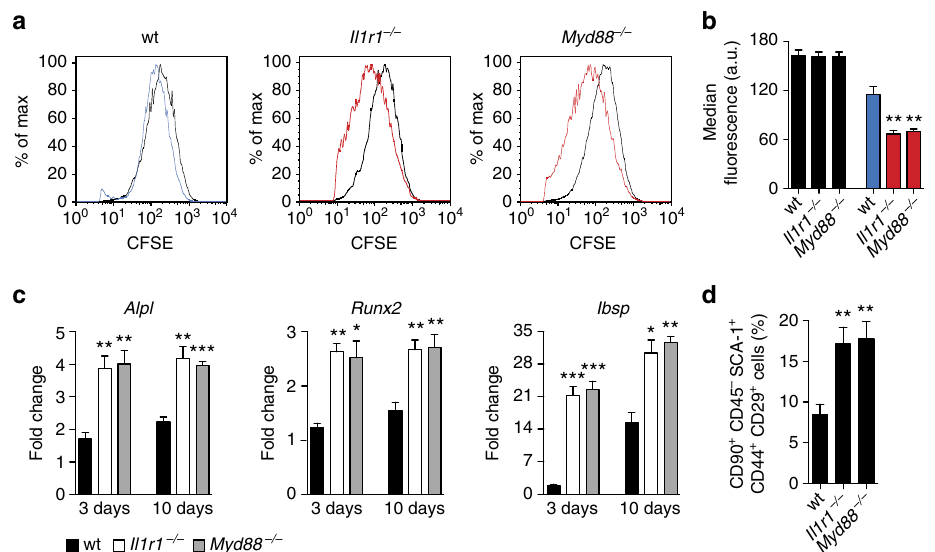
Figure 5 | Transplanted MSC functions and mobilization of MSC-like cells are inhibited by IL-1R1/MyD88 signalling. ( a – c ) Carboxyfluorescein succinimidyl ester (CFSE)-labelled MSCs from wt, Il1r1 (cid:2) / (cid:2) or Myd88 (cid:2) / (cid:2) mice were delivered into wt mouse calvarial defects (5mm diameter) within a fibrin matrix. After 7 days, partially remodelled fibrin matrices were removed from the defect and digested to recover cells. ( a ) Difference in proliferation between wt, Il1r1 (cid:2) / (cid:2) and Myd88 (cid:2) / (cid:2) MSCs was determined by comparing their fluorescence intensity using flow cytometry. MSC proliferation is inversely proportional to the fluorescence intensity. Representative histogram plots are shown. Black curves represent cells cultured in vitro with 1% serum (no proliferation control). ( b ) Median fluorescence of MSCs 7 days after implantation. Data are means ± s.e.m. ( n ¼ 3). ** P o 0.01; Student’s t -test. ( c ) CFSE-labelled MSCs were sorted by fluorescence-activated cell sorting and further cultured in osteogenesis induction medium. Expression of osteoblast-specific genes was determined by quantitative PCR, after 3 and 10 days. Fold changes in gene expression relative to MSCs cultured in normal medium are shown. Alpl , alkaline phosphatase; Runx2 , runt-related transcription factor 2; Ibsp, integrin-binding sialoprotein. ( d ) Calvarial defects in wt, Il1r1 (cid:2) / (cid:2) or Myd88 (cid:2) / (cid:2) mice were treated with fibrin matrices containing PDGF-BB (1 m g). After 7 days, fibrin matrices were recovered and digested to recover cells. Percentages of MSC-like cells (CD90 þ , CD45 (cid:2) , Sca-1 þ , CD44 þ and CD29 þ cells) recruited within the matrices were analyzed by flow cytometry. Data are means ± s.e.m. ( n ¼ 6 per condition). * P o 0.05, ** P o 0.01, *** P o 0.001; Student’s t